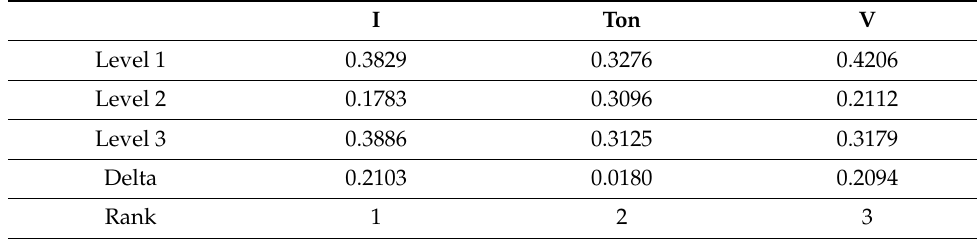
Table 4. Response table for sample A.